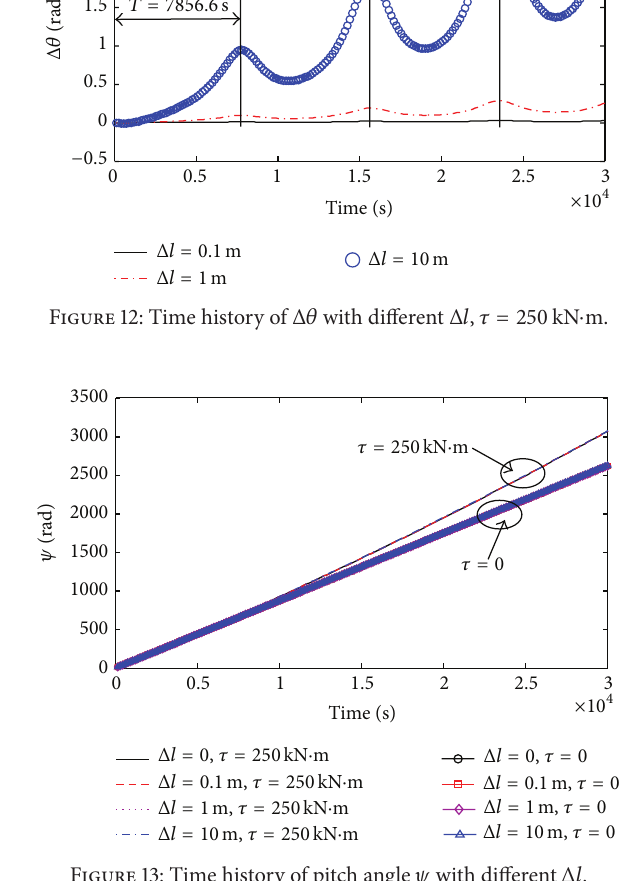
Figure 13: Time history of pitch angle 𝜓 with different Δ𝑙